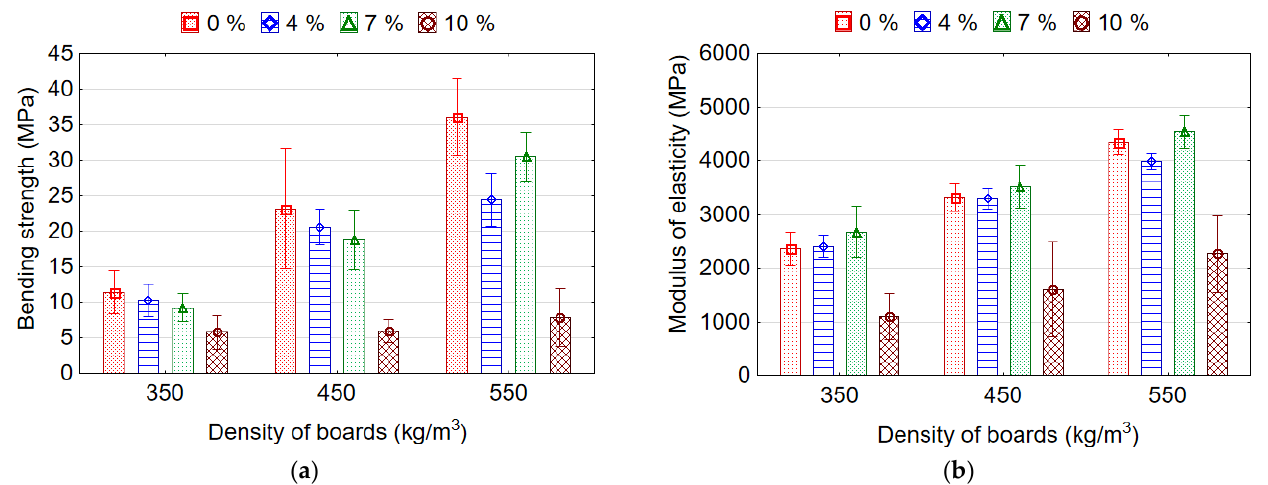
Figure 4. Bending strength ( a ) and modulus of elasticity ( b ) of lightweight veneered particleboards.